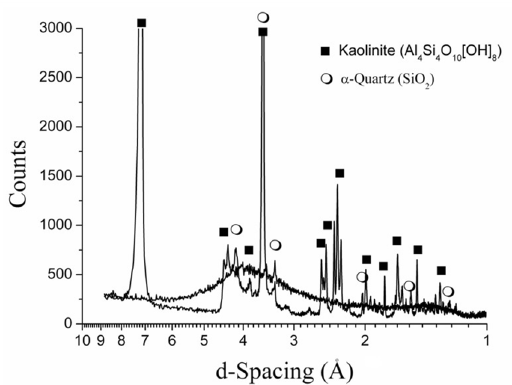
Figure 1 shows the X-ray diffractograms of kaolin (a) as received and (b) after calcination at 850 o C/2 h, or metakaolin. As can be seen, all peaks relative to the kaolinite mineral disappeared after calcination, showing that the dehydroxylation was complete.